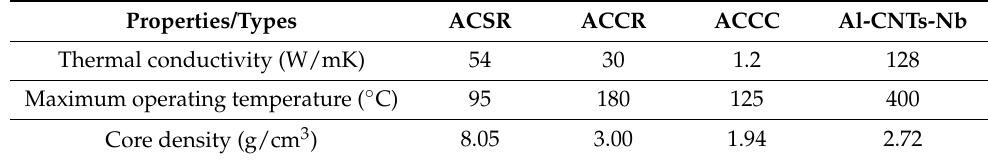
Figure 6. Features of newly developed transmission conductor [50]. Table 2. Comparative properties of transmission conductors [50].